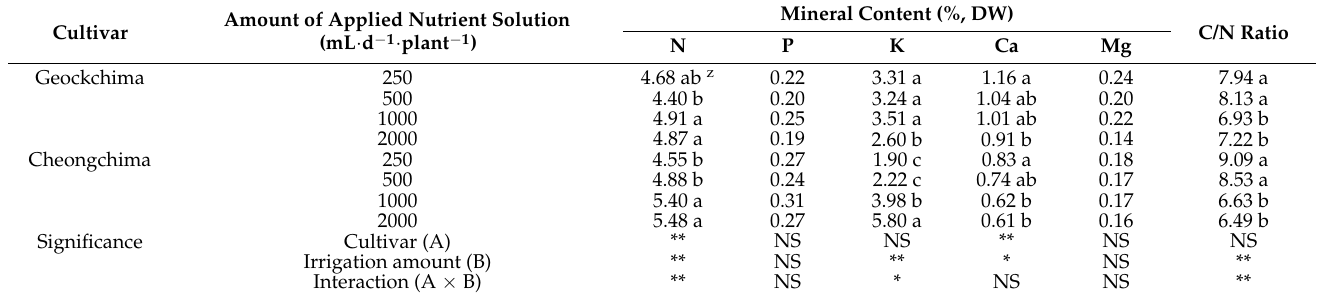
Table 4. The mineral content of leaves of two lettuce cultivars grown in perlite culture as influenced by the amount of applied nutrient